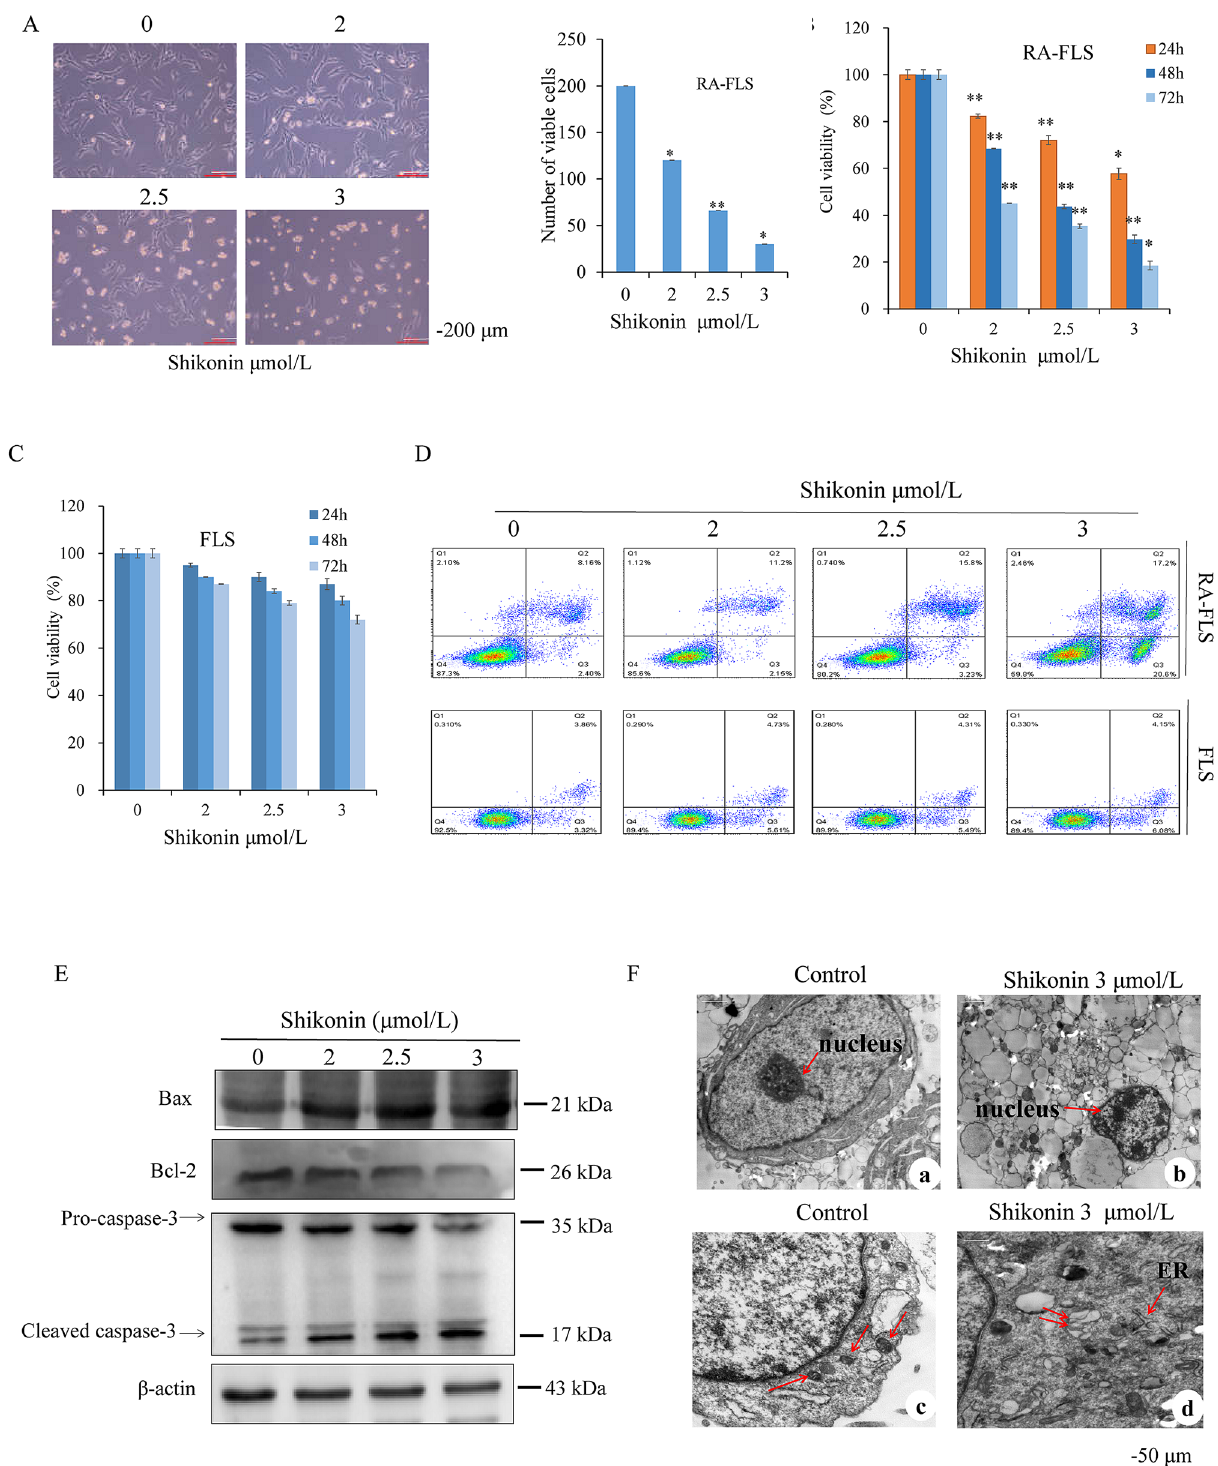
Figure 3. Inhibitory effects of shikonin on the proliferation and apoptosis of RA-FLSs. ( A ) Light microscopy showing the morphology of RA-FLSs. ( B , C ) MTT cell viability assay upon treating RA-FLSs and FLSs with shikonin for 24, 48, and 72 h. ( D ) Flow cytometry staining of RA-FLSs and FLSs with Annexin V-FITC/PI to detect RA-FLS and FLS apoptosis rates. ( E ) Apoptosis-related proteins shown in RA-FLSs by Western blot. ( F ) Transmission electron microscopy showed the submicroscopic structure of RA-FLSs from the control group and the shikonin group after 24 h of treatment with shikonin. * p < 0.05, ** p < 0.01 vs the Control group. Scale bar represents 50 μm. Data are representative of at least three independent